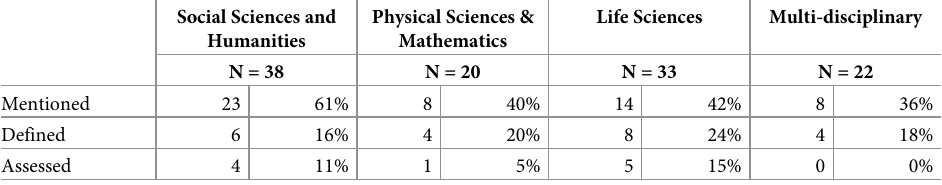
Table 6. RPT documents’ relevant references to collegiality and related terms in R-Type institutions by discipline. Social Sciences and Humanities Mentioned